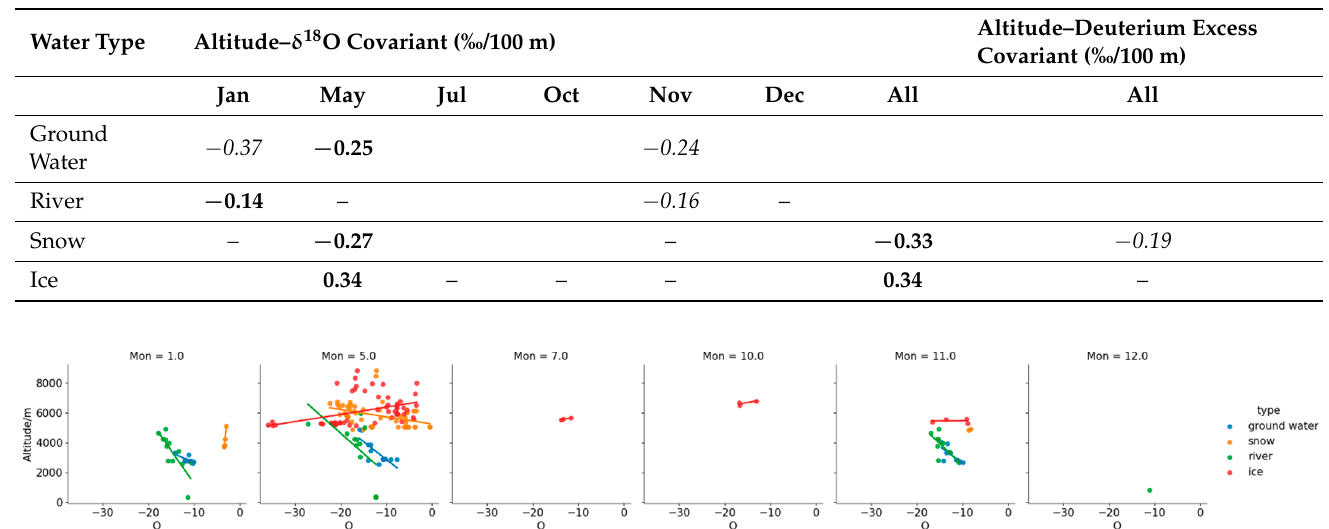
Figure 3. Variation in surface water δ 18 O with altitude in different months. Numbers on top of each panel represent sampling month.